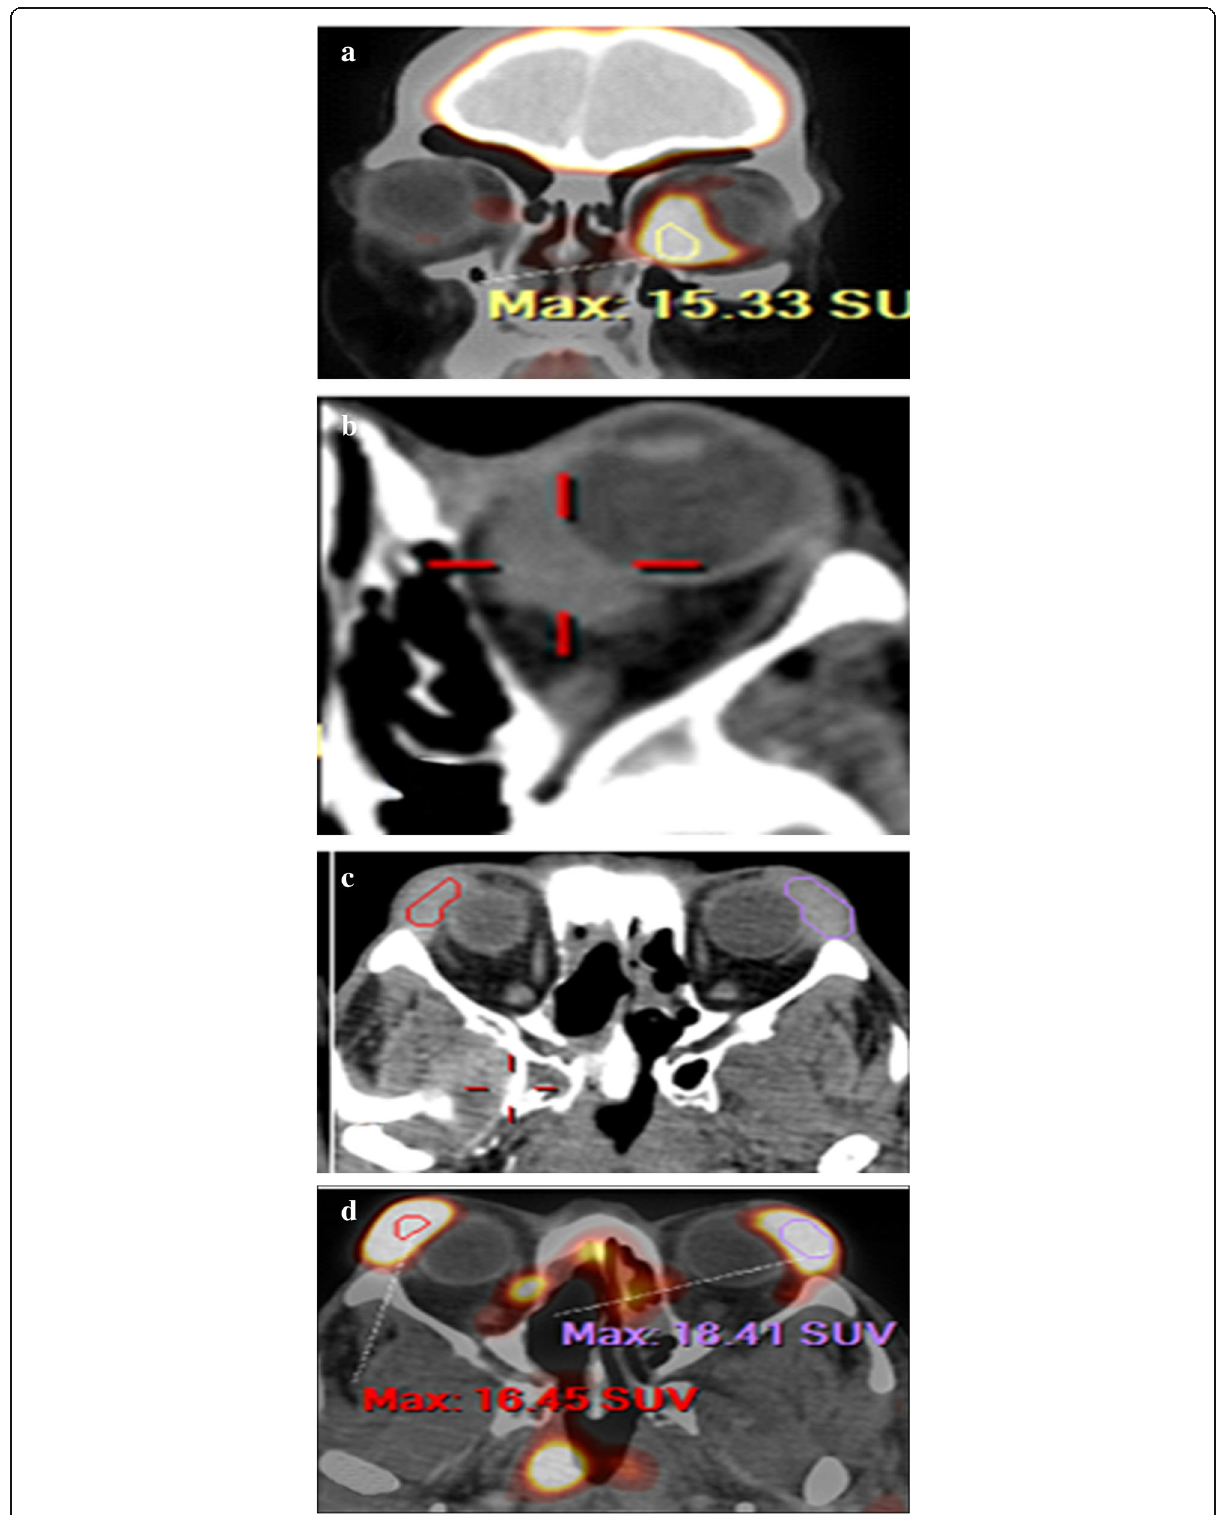
Fig. 3 Orbital lymphoma: two different cases. a , b A well-defined homogenous soft tissue lesion, pathologically proven NHL, occupying the infero-medial aspect of left orbital cavity, infiltrating the inferior and medial recti, sparing the optic nerve. c , d Bilateral intensely avid lacrimal gland